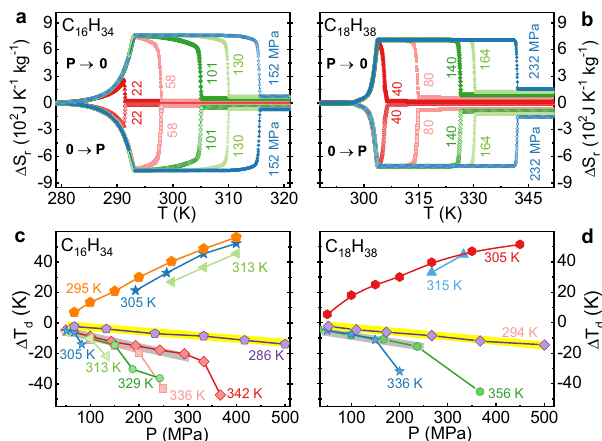
Fig. 1 The reversible isothermal entropy change ( Δ S r ) and adiabatic temperature change measured by the direct method ( Δ T d ). Δ S r under different pressures for C 16 H 34 ( a ) and C 18 H 38 ( b ); Δ T d values for C 16 H 34 ( c ) and C 18 H 38 ( d